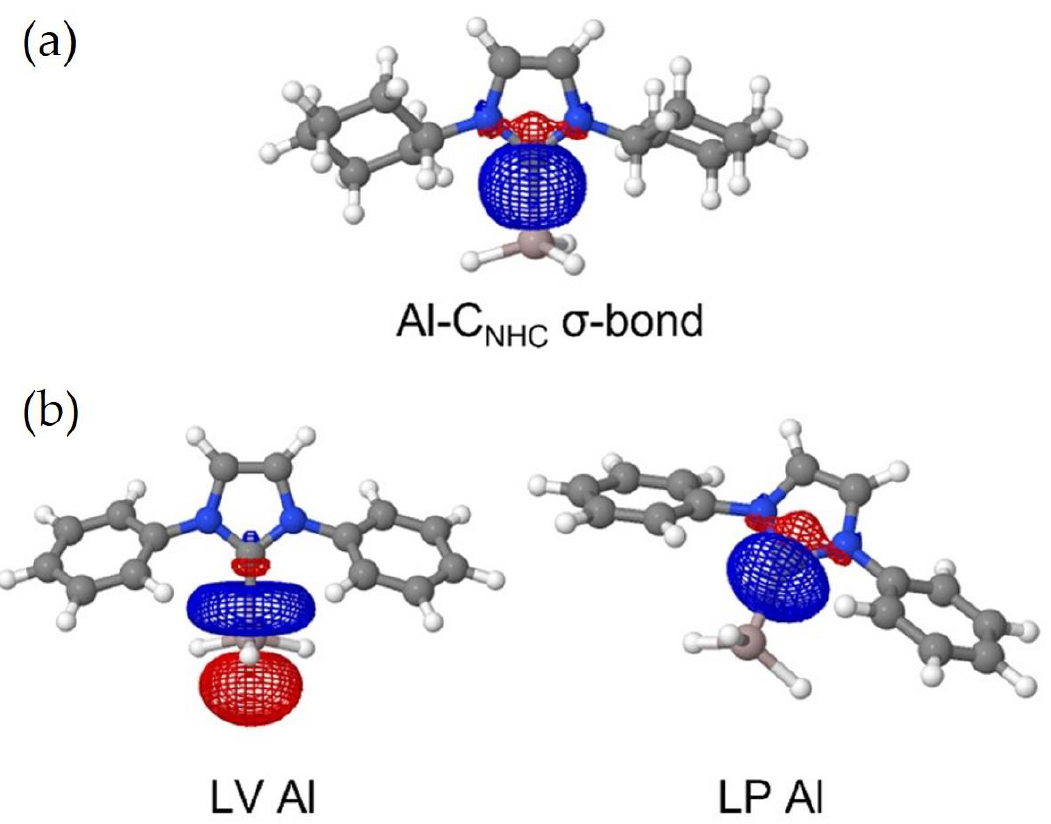
Figure 5. NBO visualisations for ( a ) ICyAlH 3 and ( b ) IPhAlH 3 . LV = lone valency, LP = lone pair.